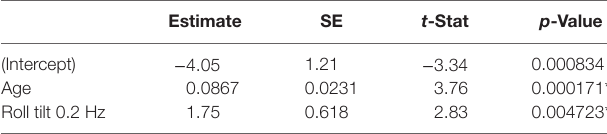
Analyses were done using age-adjusted, log-transformed thresholds. *Signifies statistical significance (p < 0.05).